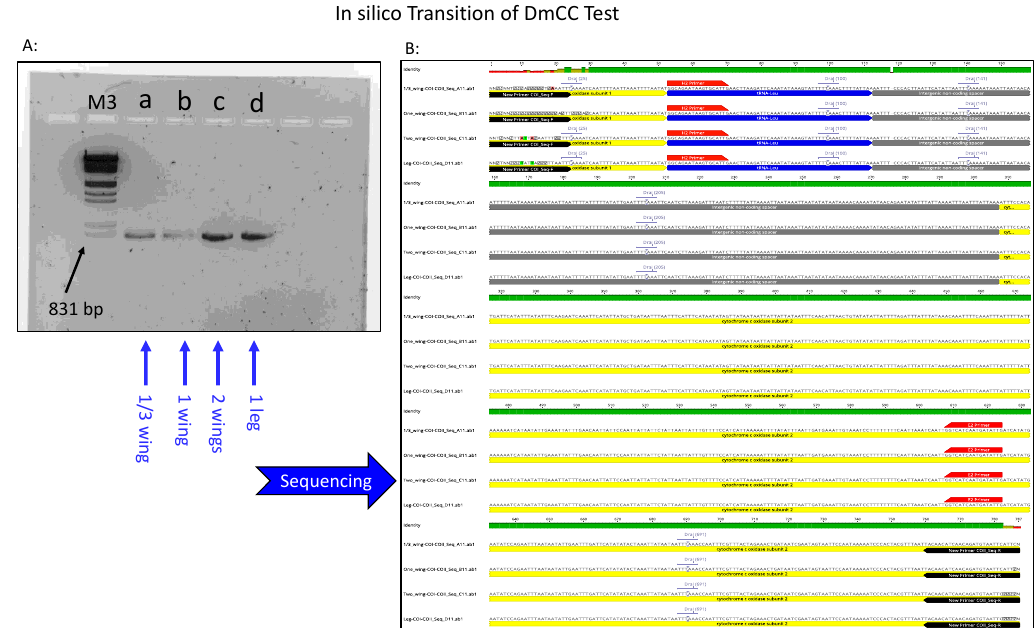
Figure 4. Transition of the DmCC test to in silico. ( A ): Amplification of the COI-COII region using a new proposed primer (COI_Seq-F and COII_Seq-R) revealed on 1.5% agarose gel. Ladder M3 is Lambda DNA/HindIII; samples a, b, c, and d, are one-third, one, two wings and one queen leg, respectively. ( B ): Sequences of the PCR amplicons showing the structural organization of the extended amplified region, location of the new primer (black), original primer (H2–E2) in red, cytochrome c oxidase subunit 1 and 2, tRNA-Leu, Q non-coding fragment and DraI restriction sites.